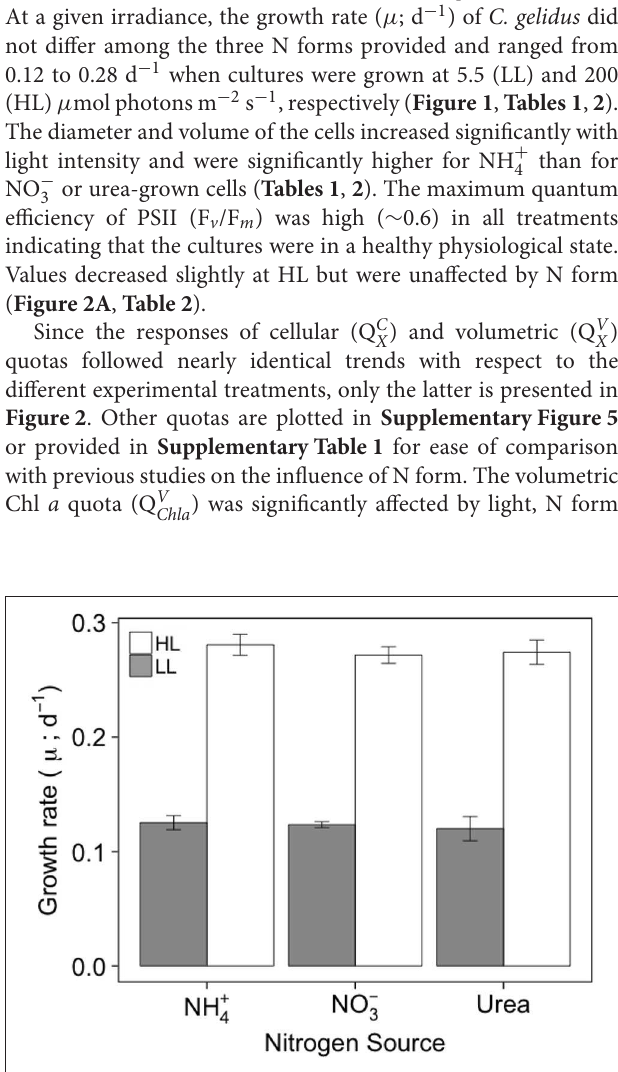
FIGURE 1 | Growth rate of C. gelidus acclimated to NH + 4 , NO − 3 or urea under low (5.5 µ mol photons m − 2 s − 1 ; gray) or high (200 µ mol photons m − 2 s − 1 ; white) light at 0 ◦ C. Vertical lines indicate the standard deviation ( n = 3).